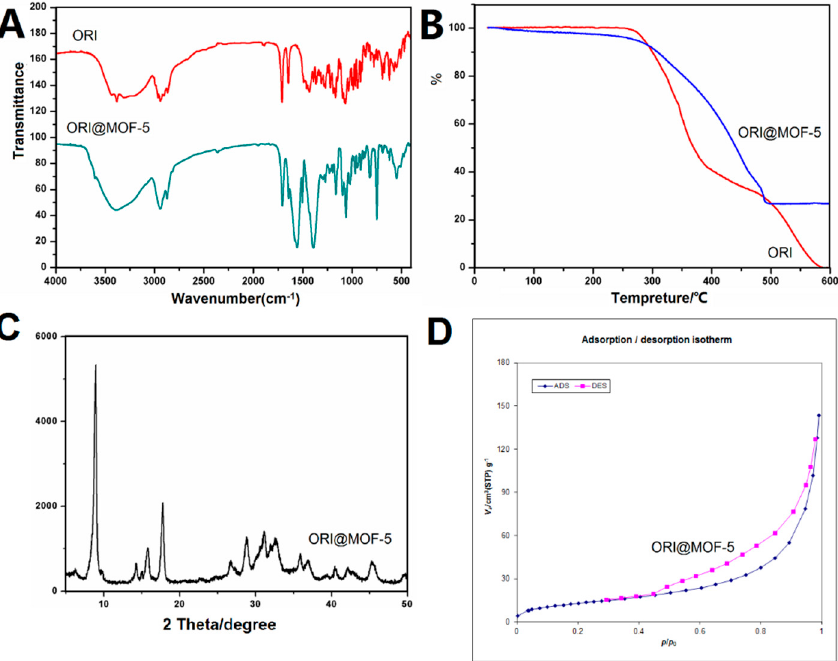
Figure 5. Particle size distribution of MOF-5-S ( A ) and MOF-5-D ( B ); ( C ) Brunauer–Emmett–Teller (BET) isotherm of MOF-5-S and MOF-5-D at 77 K.